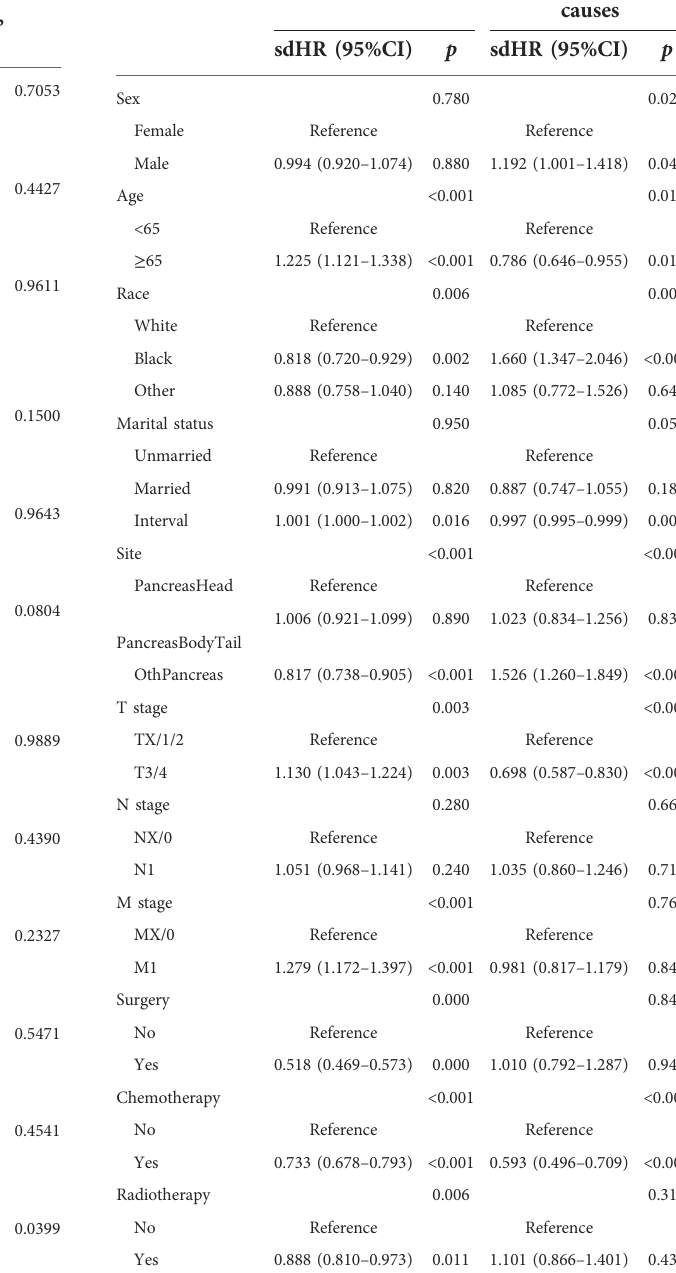
TABLE 3 Demographics of training and validation sets. TABLE 4 Competing risk models for mortality from pancreatic ductal adenocarcinoma and death from other causes. Characteristics Death from